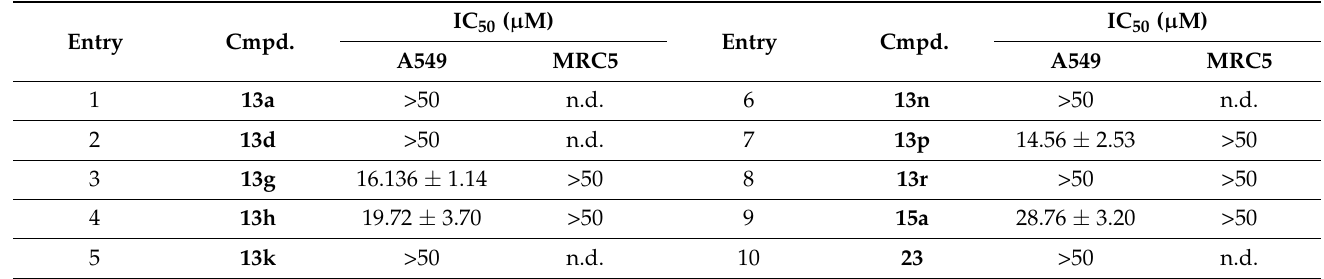
Table 1. Antiproliferative activity of α -aminophosphonate derivatives 13 , 15 and 23 . Entry